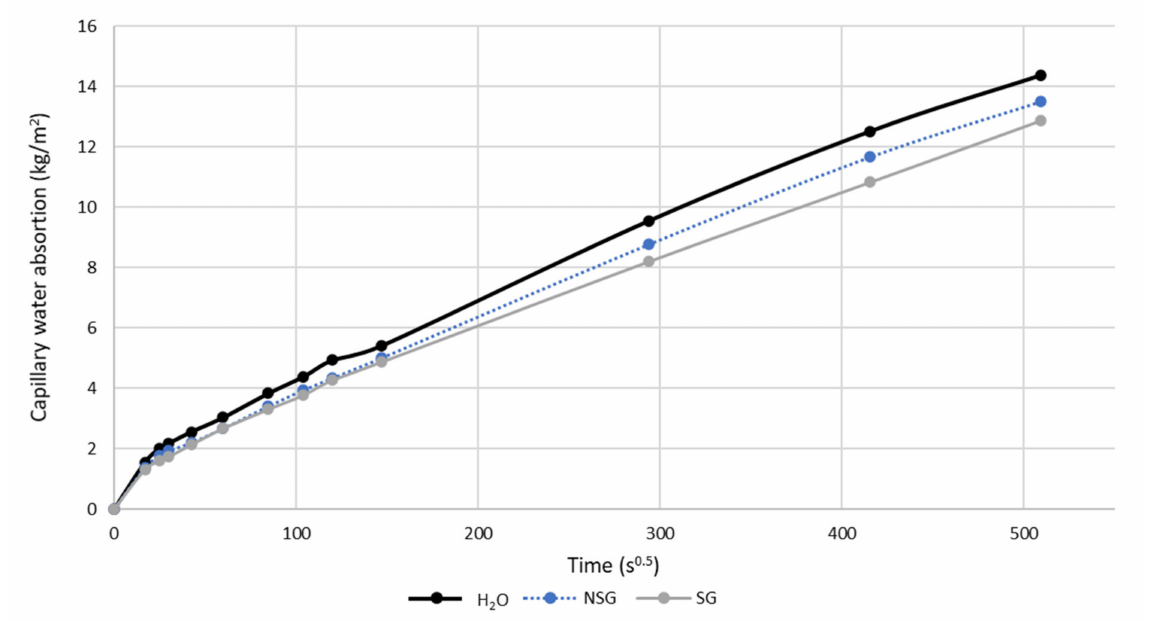
Figure 4. Result of water absorbed by capillarity test on concrete, treated with non-sonicated glycerol (NSG), sonicated glycerol (SG), and water.